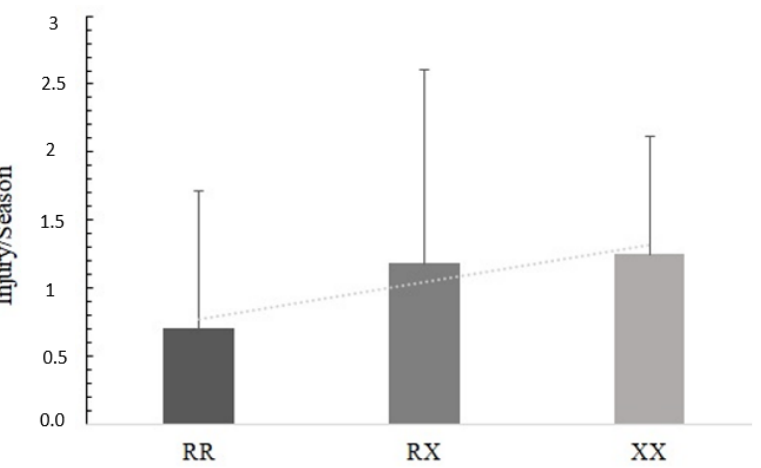
Figure 2. Trend p -value of the ACTN3 R577X genotypes and injury per season. There is an increase following the order XX > RX > RR ( p = 0.045).